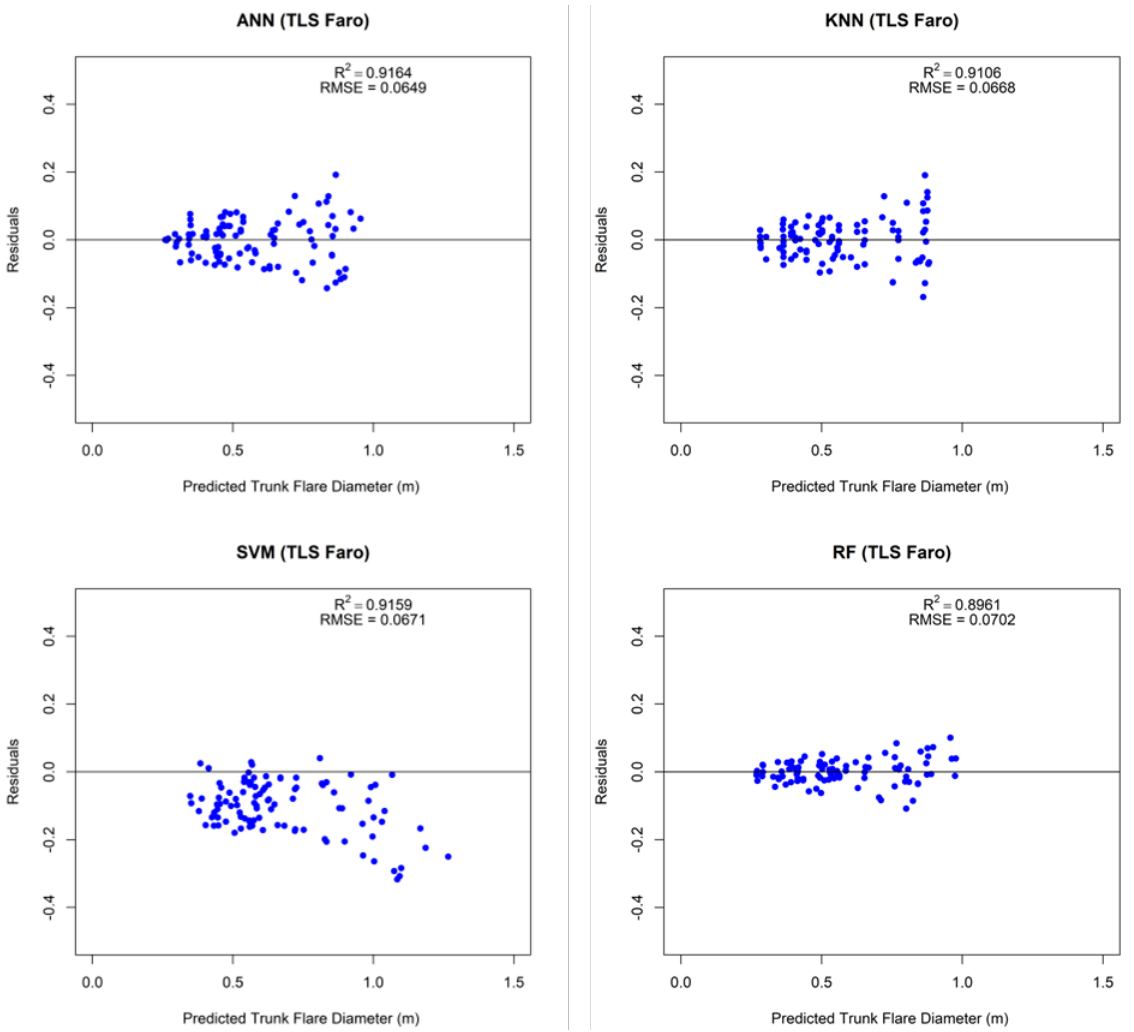
Figure 10. Graphics for the distribution of the residuals according to the predicted trunk flare diameter from four different algorithms using TLS FARO data.